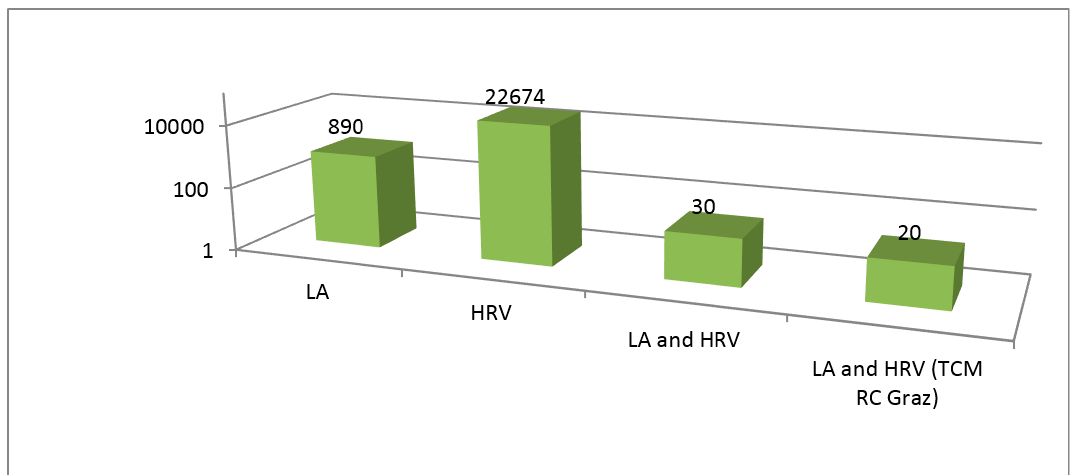
Figure 1. Number of scientific articles (PubMed, 3 May 2018) on laser acupuncture (LA) and heart rate variability (HRV). TCM RC Graz (Traditional Chinese Medicine Research Center Graz).